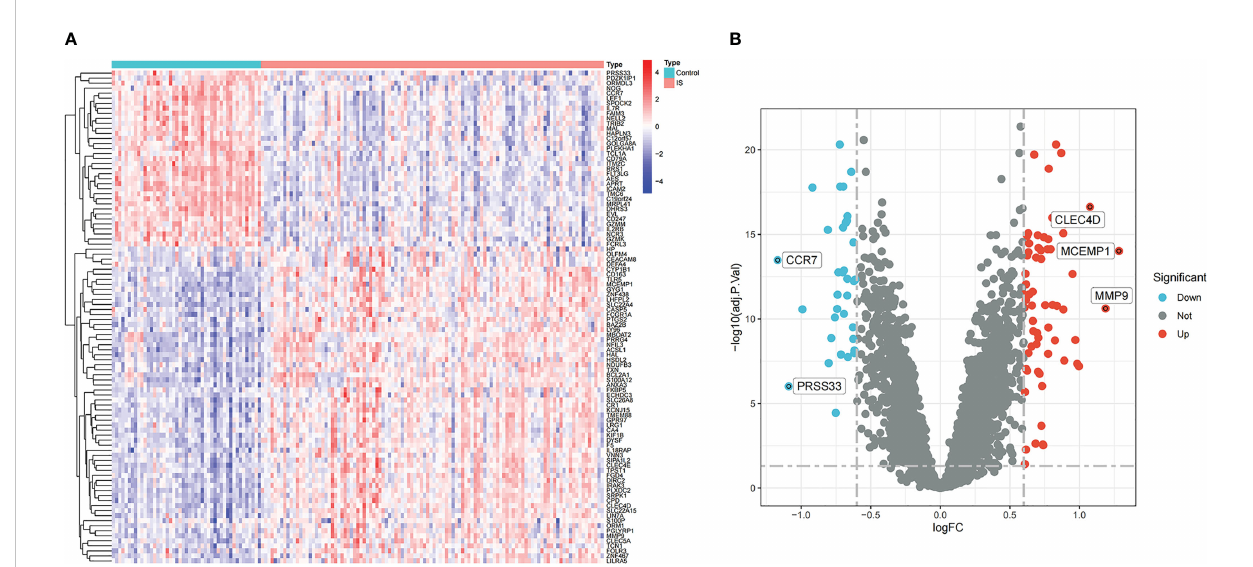
FIGURE 2 DEGs identi fi cation in the integrated IS dataset. (A) Rows represent DEGs, and each column refers to a sample. Red and blue represent upregulated and downregulated DEGs, respectively. (B) Red and green circles represent upregulated and downregulated DEGs,